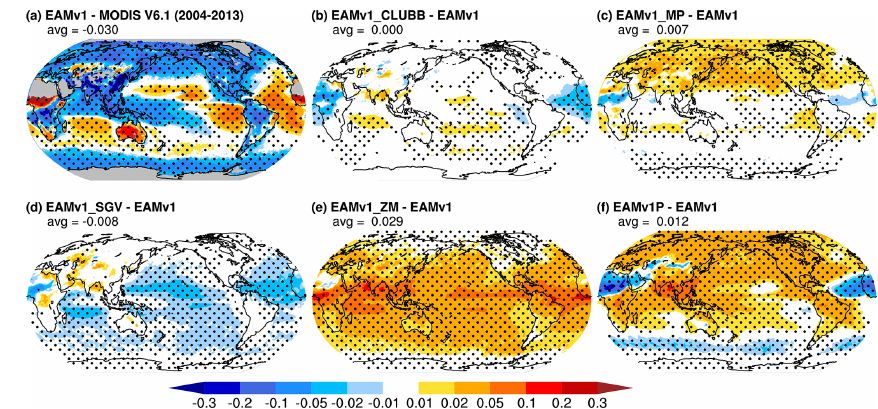
Figure 12. Clear-sky aerosol optical depth ( τ aer ). The MODIS onboard Aqua τ aer data product (Levy et al., 2013) is used for comparison with EAMv1. Model clear-sky τ aer is sampled at